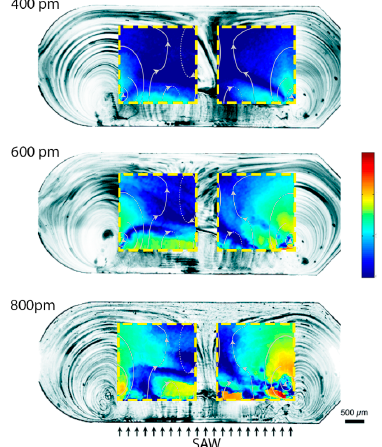
Figure 5. SAW-induced streaming characterization for different wave amplitudes. The streamlines of the fluid flow in the microchannel are shown for three different powers. The micro particle image velocimetry ( μ PIV) velocity fields on the two gold SPR areas are superimposed to the streamlines. The color bar represents the logarithm of the velocity and ranges from 10 μ m s − 1 to 1800 μ m s − 1 .